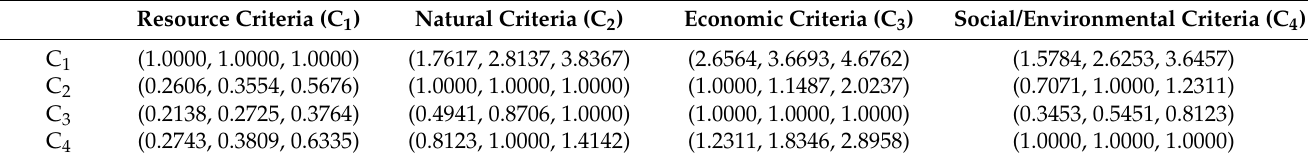
Table A6. Fuzzy pairwise comparison matrix by